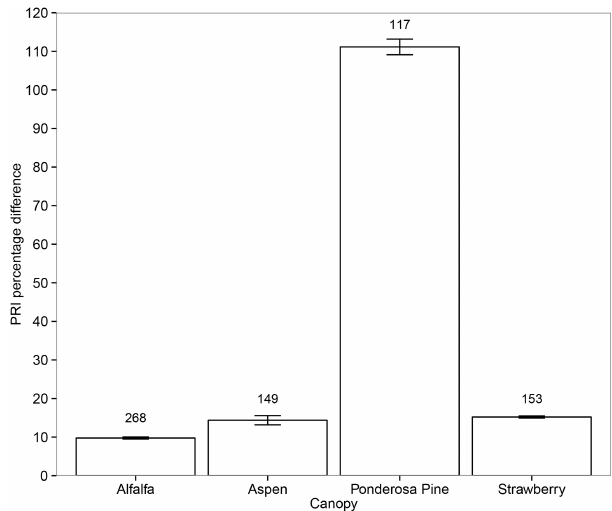
Figure 4. Plant canopy dependencies of UniSpec DC photochemi- cal reflectance index (PRI) vs. SKR 1800 PRI across a range of plant canopies during a series of dark-to-light transitions. Per-canopy mean percentage differences are plotted along with 95% confidence intervals. The sample sizes (number of pairs) used to compute the mean differences and confidence intervals are given at the tops of the bars. Data shown are those that have been corrected to normalize the SRF differences between